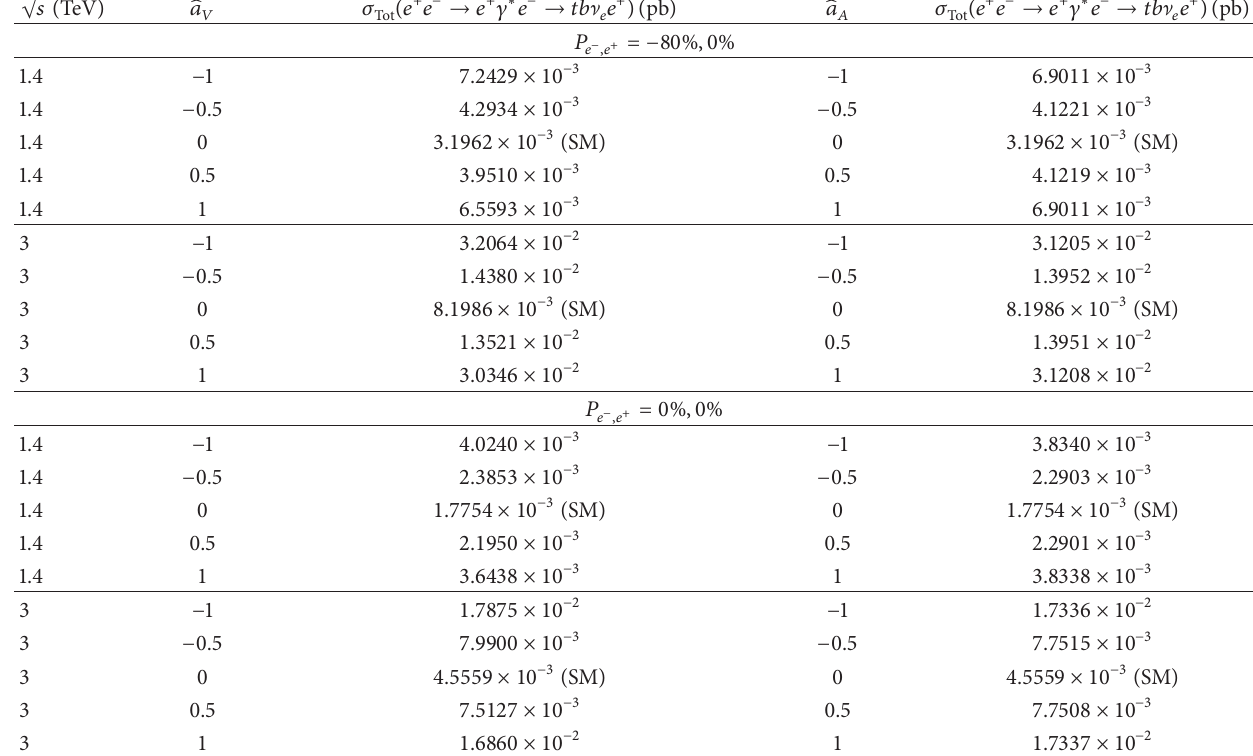
Table 6: Total cross sections for the process 𝑒 + 𝑒 − → 𝑒 + 𝛾 ∗ 𝑒 − → 𝑡𝑏 ] 𝑒 𝑒 + ( 𝛾 ∗ is the Weizsacker-Williams photon) as a function of ̂𝑎 𝑉 and ̂𝑎 𝐴 for 𝑄 2 =